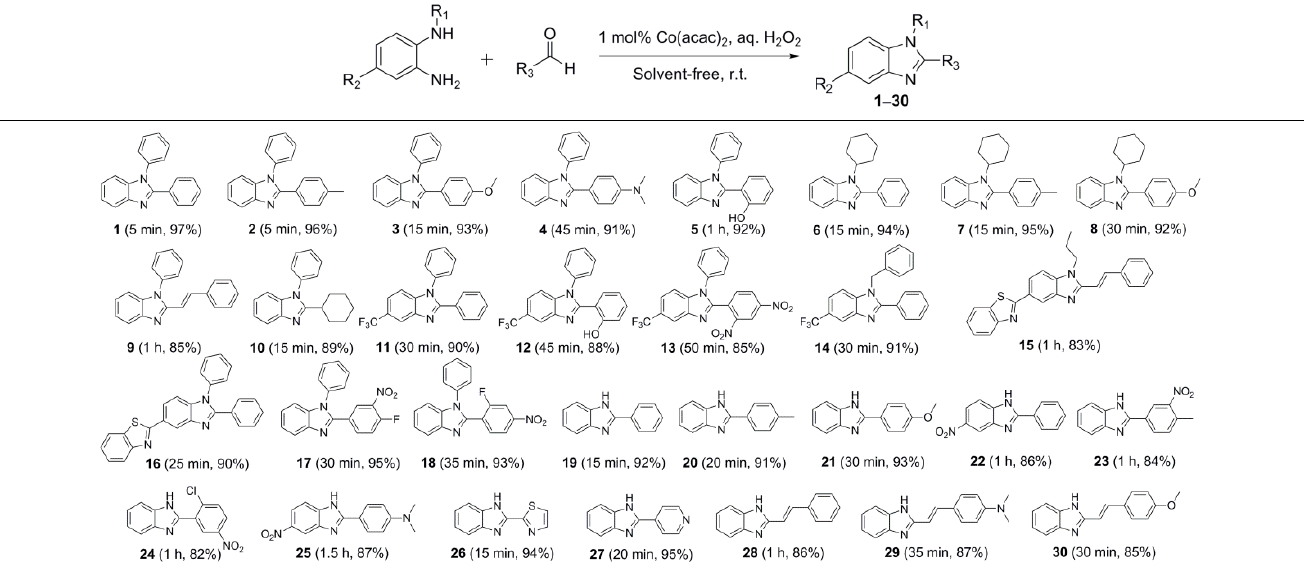
Table 4. Synthesis of benzimidazoles ( 1 – 30 ) via Co(III)/Co(II)-mediated redox catalysis 1 .